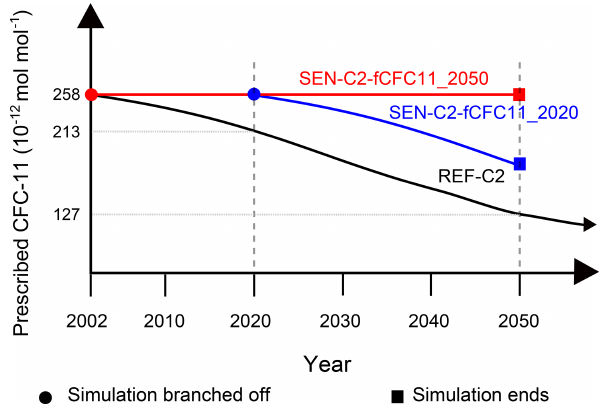
Figure 1. Schematic of the EMAC model simulations performed: a reference simulation (REF-C2) and two sensitivity simulations (SEN-C2-fCFC11_2020 and SEN-C2-fCFC11_2050) enabling an assessment of enhanced CFC-11 surface mixing ratios on the ozone layer. The prescribed CFC-11 surface mixing ratios are given on the nonlinear vertical axis. The prescribed CFC-11 surface mixing ratios are based on Table 5A-3 in Daniel et al.